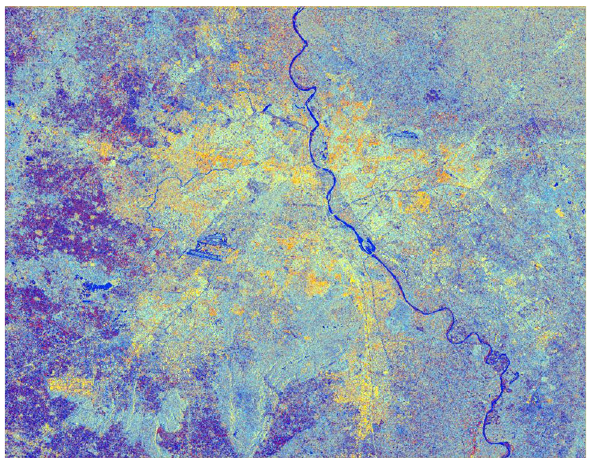
Figure 16. Colour composite image (Red: VV, Green: VH, Blue: VH/VV) of the Sentinel-1 dual-polarization C-band data in with a window size of 9 and sigma value of 0.5.